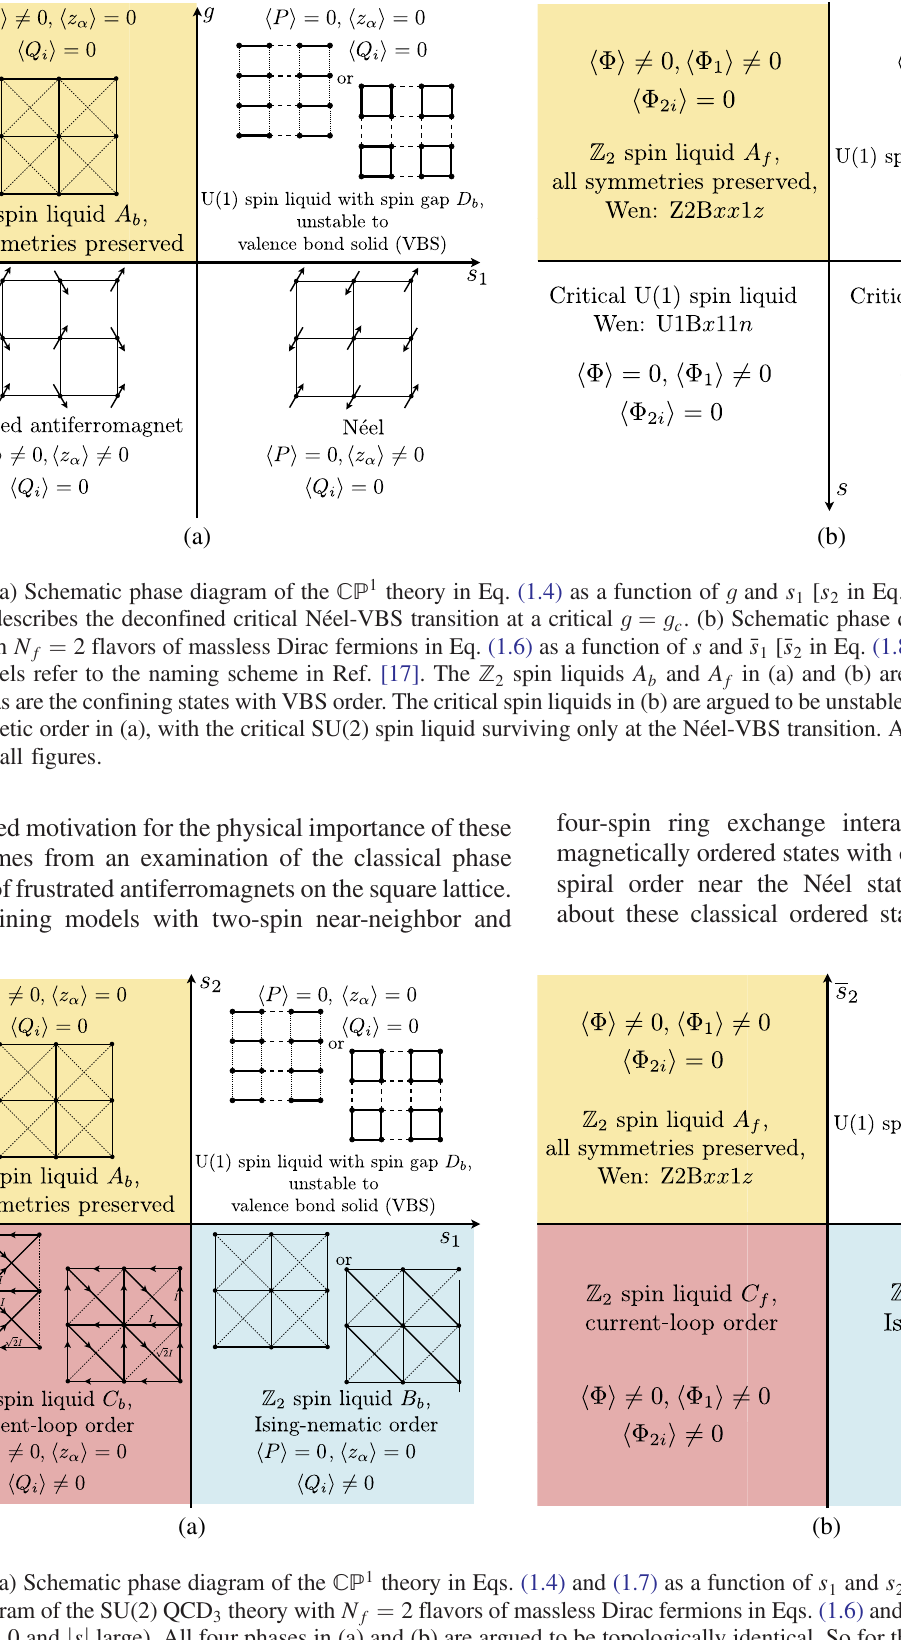
1 and 2 spin liquids, A b ¼ A f ,